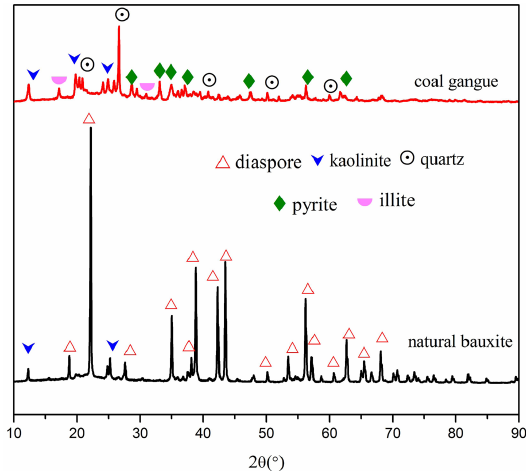
Figure 1. XRD patterns of the raw